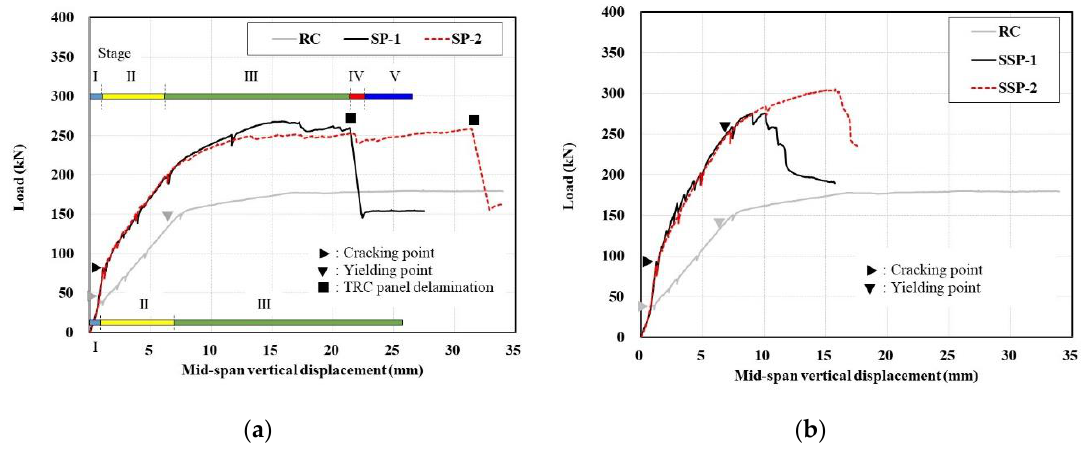
Figure 9. Load-displacement curve of TRC panel reinforced specimens: ( a ) SP series; ( b ) SSP series.